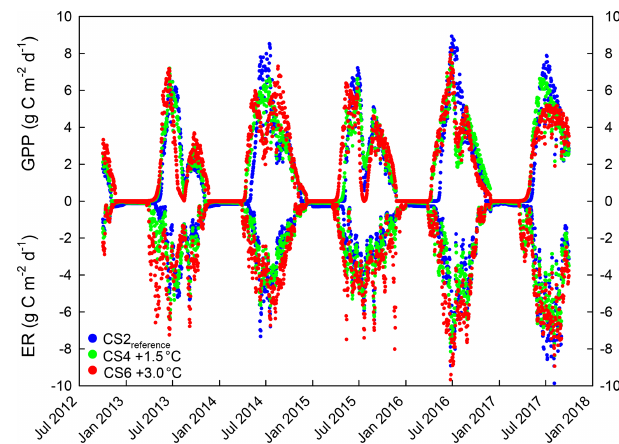
Figure A2. Daily flux sums (mean) of CO 2 gross primary produc- tivity (GPP) and ecosystem respiration (ER). Colored dots indicate means from six control treatment monoliths (neither irrigation nor additional N) per CS2 reference (blue), CS4 (green) and CS6 (red), respectively. The ecosystem perspective, rather than the atmosphere perspective, was assumed, resulting in negative ER values (C loss) and positive GPP values (C